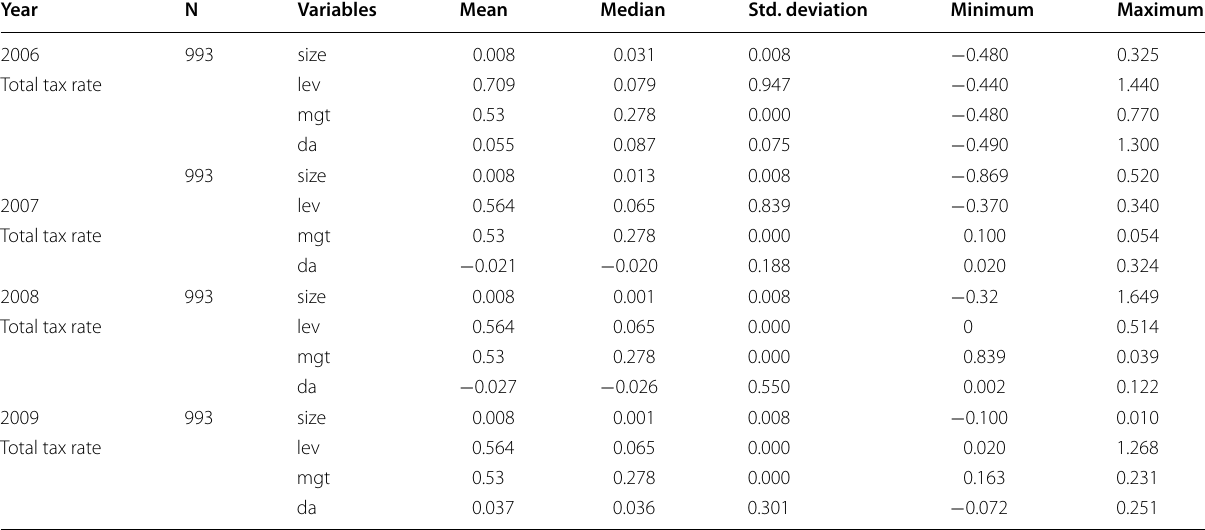
Table 7 Correlation coefficient between variables-German